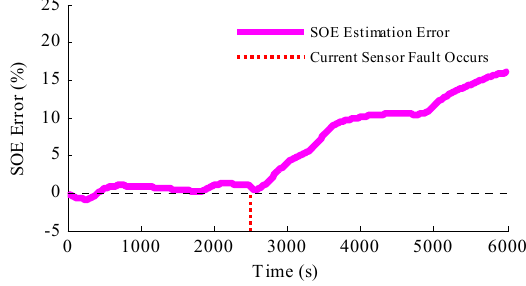
Figure 11. Experimental results when current sensor faults without taking any action.